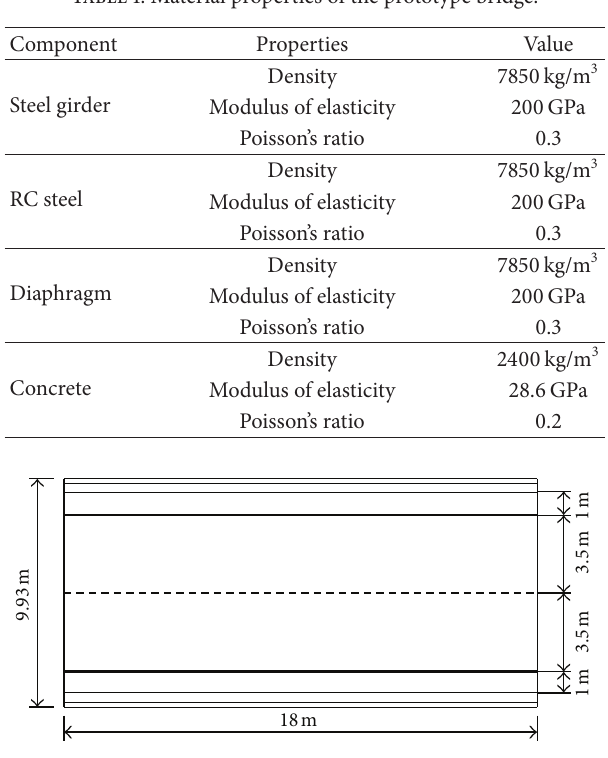
Table 1: Material properties of the prototype bridge.